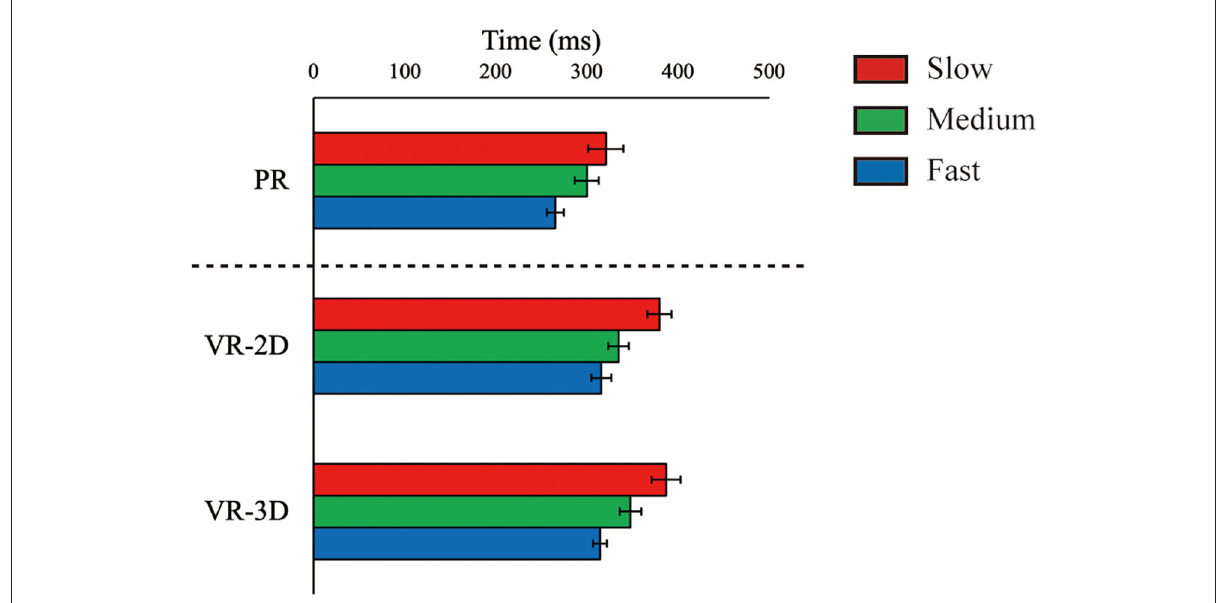
FIGURE5 Mean (error bar: SE) of the arm reaction time ( 1 T reaction ). The PR condition, shown here for visual comparison with the VR conditions, was excluded in statistical test due to technical imcomparability in data recording (see main text).